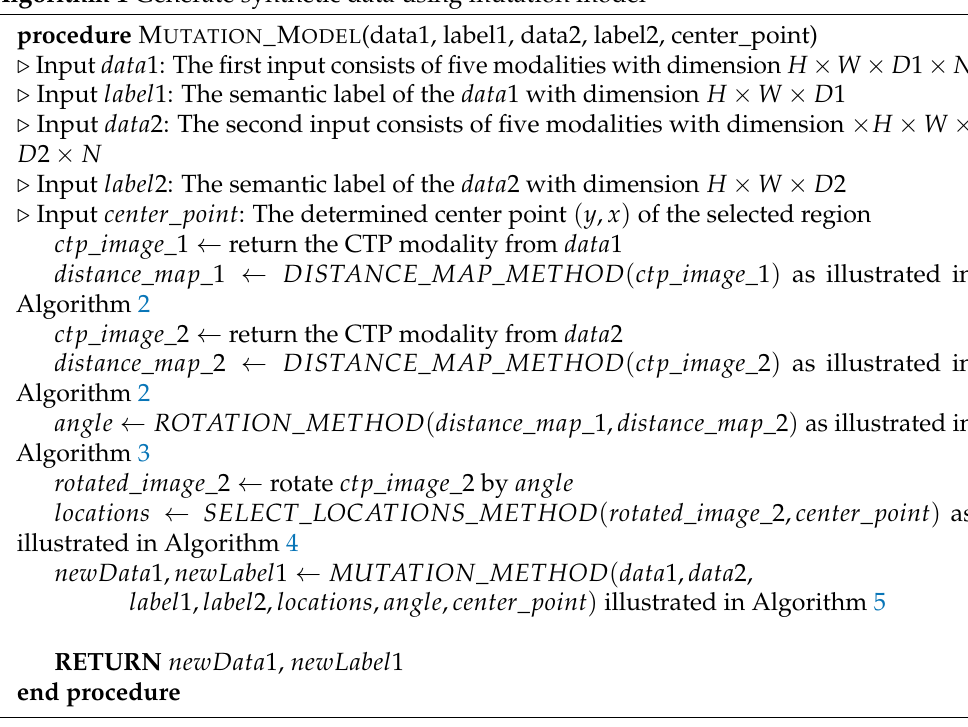
Algorithm 1 Generate synthetic data using mutation model